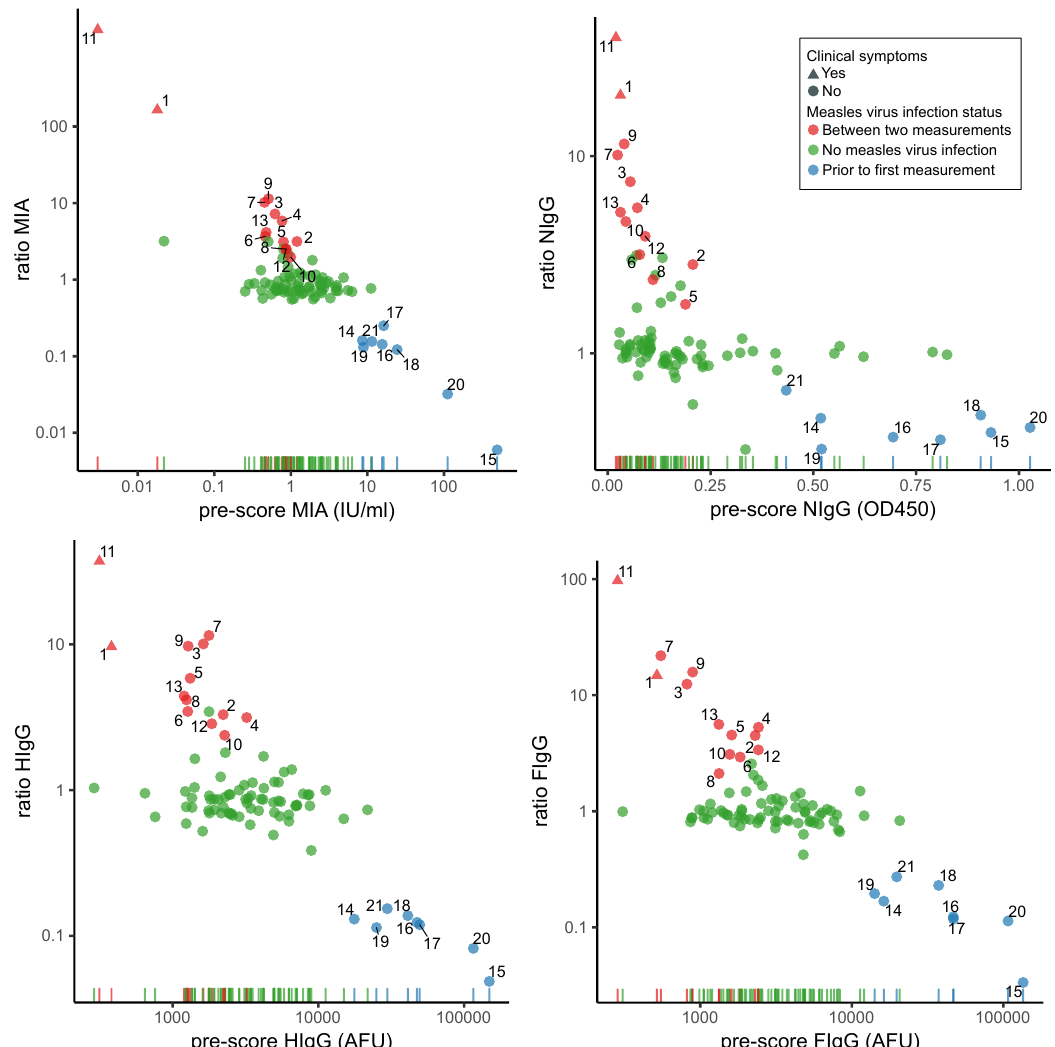
Figure 1. Ratios of pre- and post-measurements of measles specific antibody concentrations by pre-outbreak results of 91 children. The colors indicate the classification based on the k-means clustering analyses. Numbers provide a comparison of samples across the di ff erent tests. MIA: bead-based multiplex immunoassay; FIgG: immunofluorescence assay to detect antibody levels specific for MV-F protein; AFU: arbitrary fluorescence units; HIgG: immunofluorescence assay to detect antibody levels specific for MV-H protein; NIgG: indirect EIA to detect antibodies to MV-N